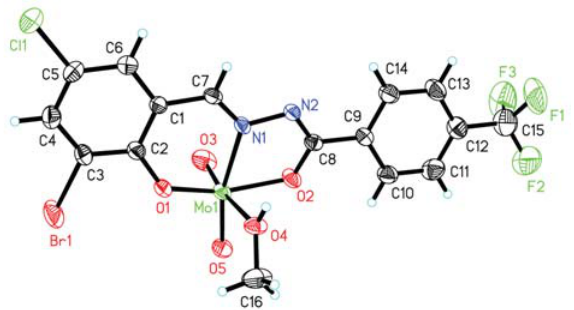
Figure 2. ORTEP plots (30% probability level) and numbering scheme for 2 .